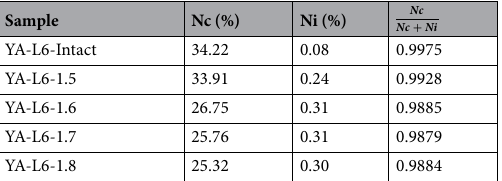
Table 3. Nc and Ni for different samples from CT scanning. N the percentage of isolated pores